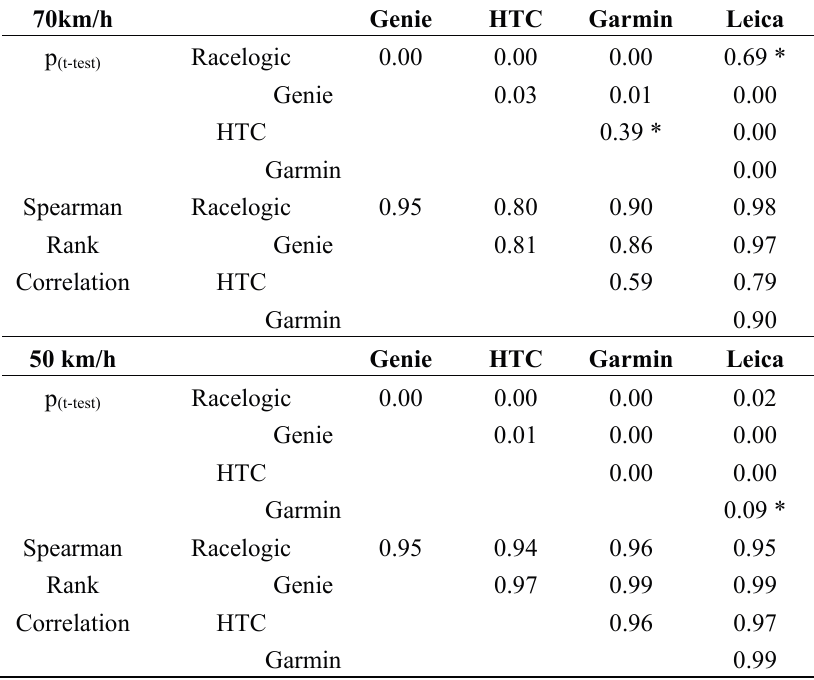
Table 5. Significance of pairwise sample t-test (p (t-test) ) and Spearman rank correlations between GNSS systems at maximum speed of 70 km/h and 50